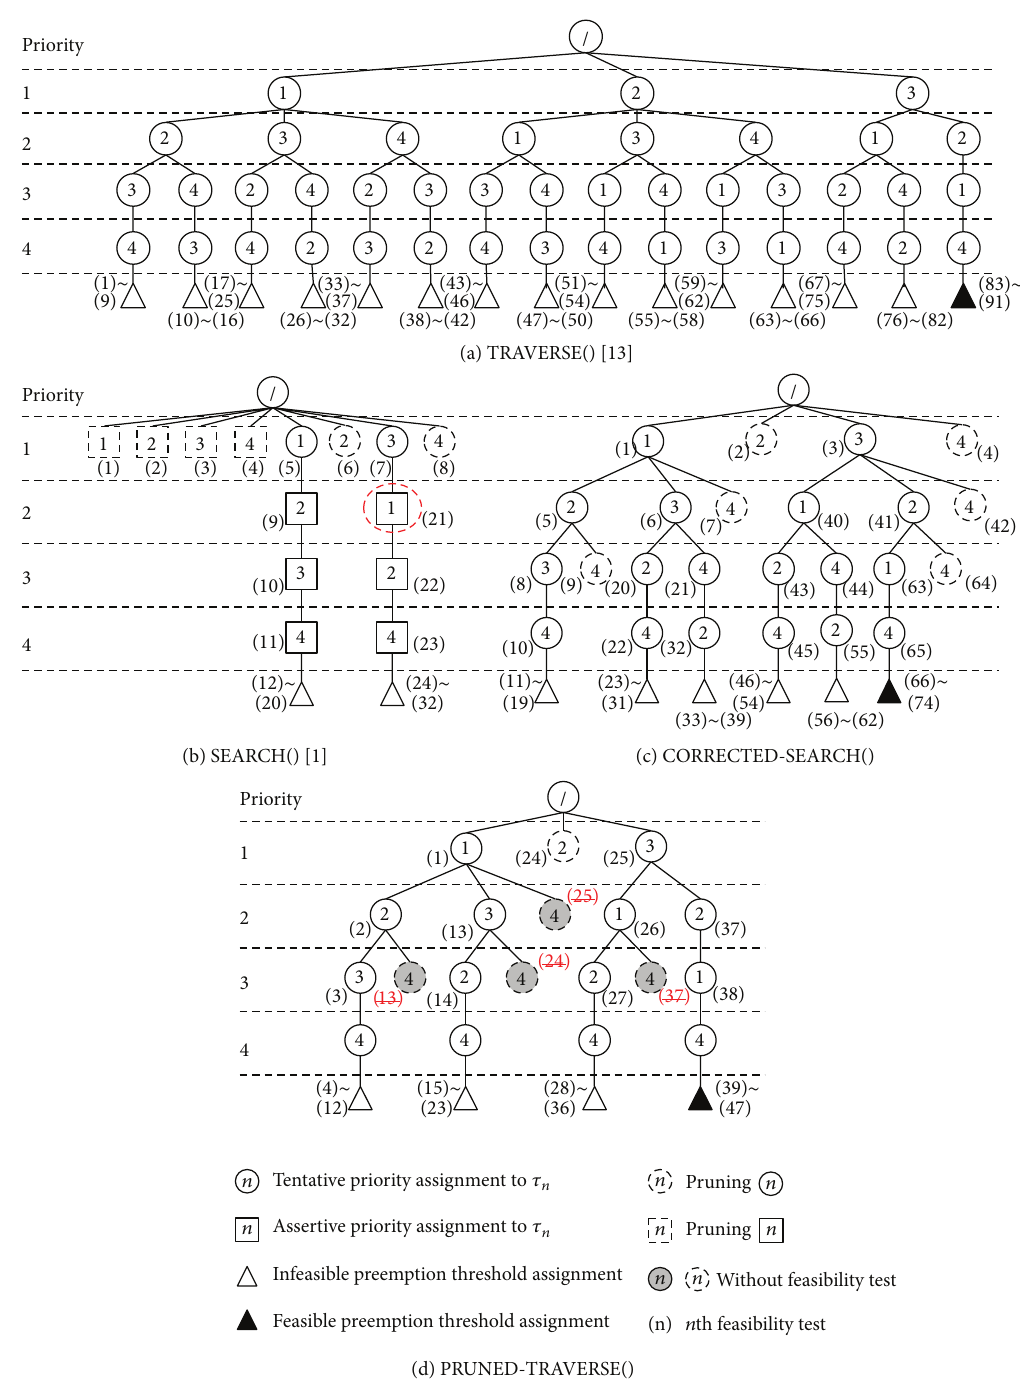
Figure 2: Priority assignment trees for the walk-through example task set of Table